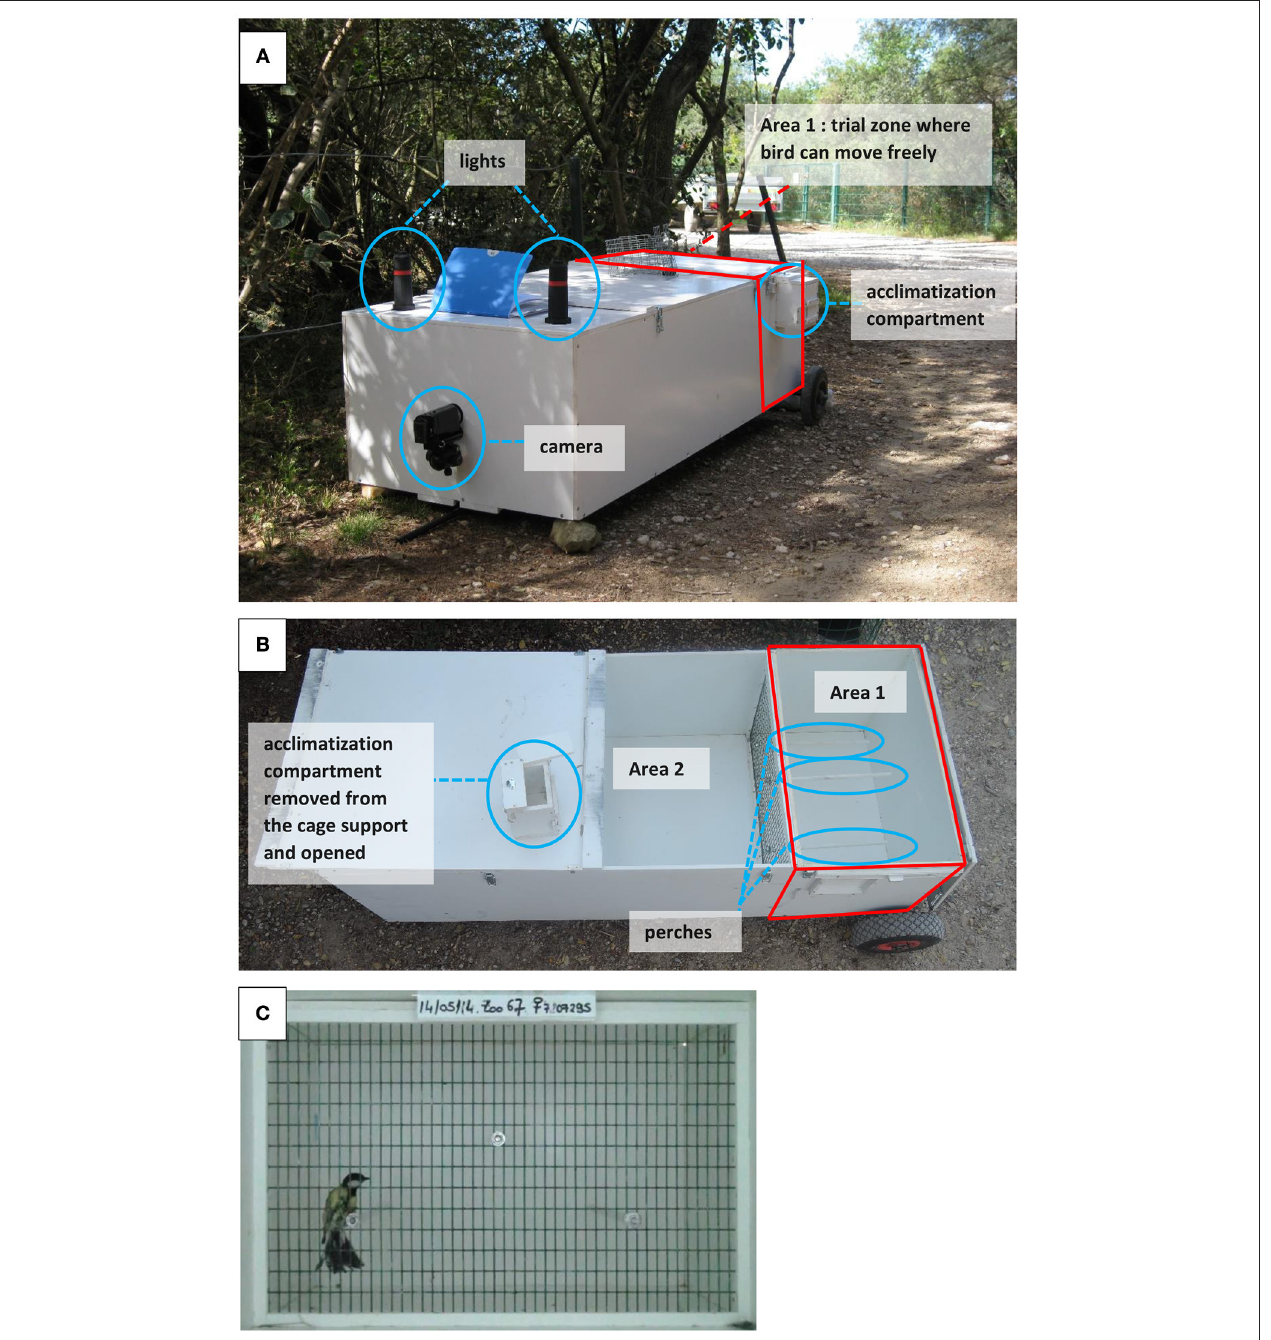
FIGURE 1 | Pictures of the experimental open-field cage for the novel environment test. (A) View of the operational cage at the zoo of Lunaret (Montpellier). (B) View from above to see the division between area 1 of the cage where the bird is released during the trial and area 2 (the rest of the cage) which serves as an empty compartment to control for distance with the camera and light conditions. (C) Picture of the movie view during a trial.